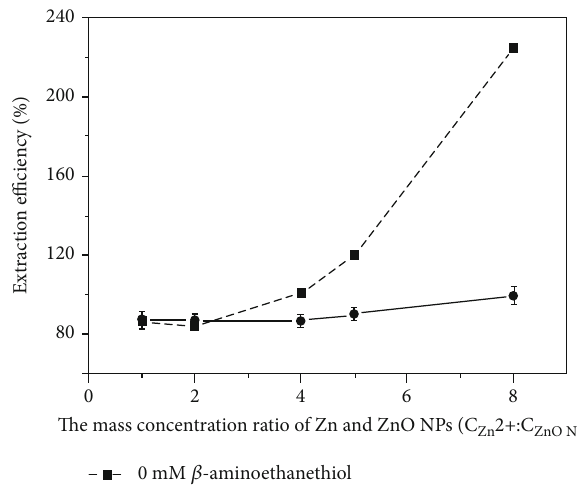
Figure 2: E ff ect of β -mercaptoethylamine on the separation of Zn 2+ and ZnONPs using the optimal CPE conditions ( n = 3